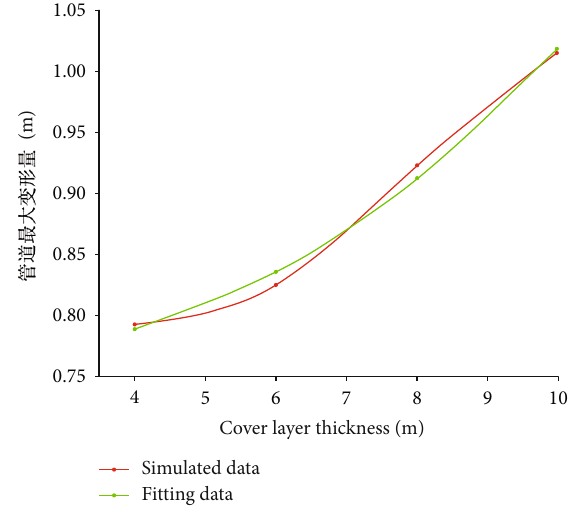
Figure 13: The pipeline maximum displacement under di ff erent cover layer thicknesses.